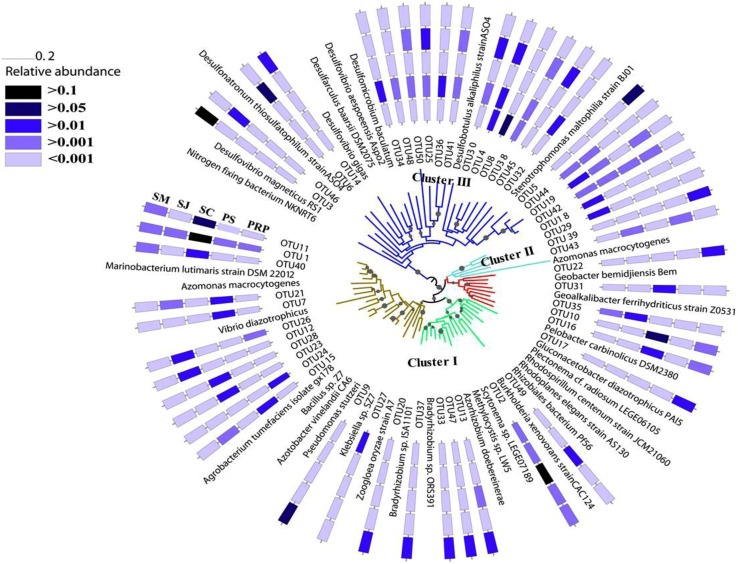
A NJ tree to show the phylogenetic relationship of the most abundant 50 OTUs with affiliated canonical nifH clusters (Chien and Zinder, 1996) indicated by colored branches. Bootstrap value greater than 50% is shown (calculated 1,000 times).